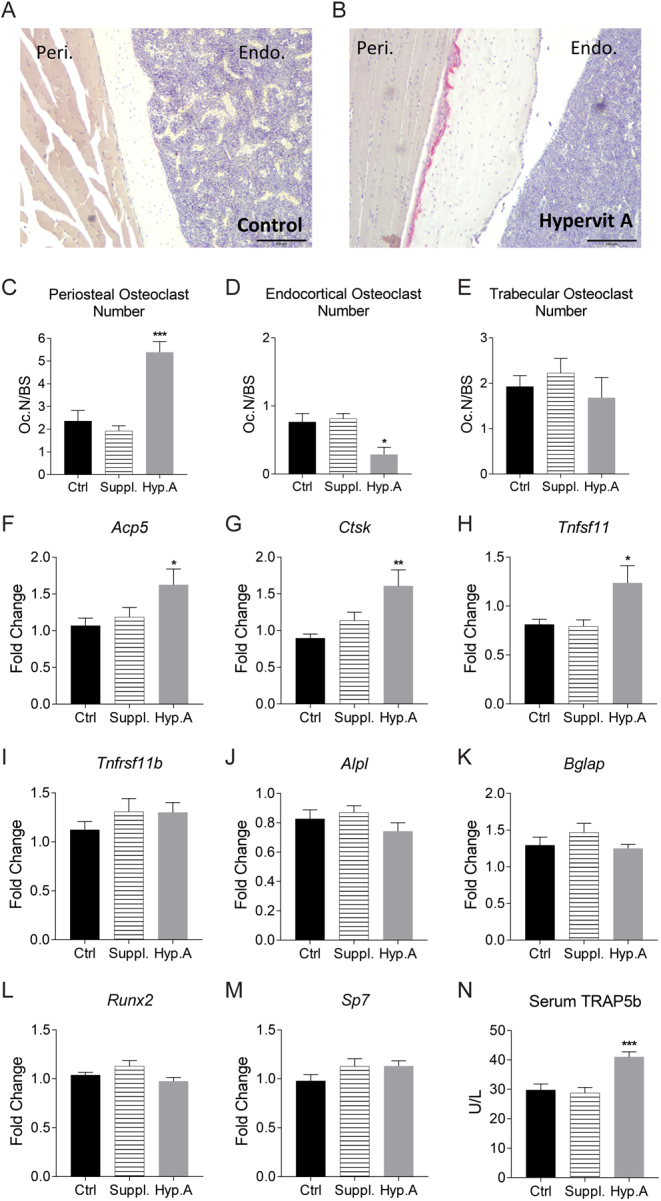
Short duration hypervitaminosis A experiment decreased cortical bone parameters, an effect caused by an increase in osteoclast number. Representative images of TRAP stained sections of femur of (A) control and (B) hypervitaminosis A treated mice for 8 days, scale bars represent 100 µm. Osteoclast numbers per measured bone surface counted from the (C) periosteum, (D) endosteum, and (E) trabeculae in TRAP stained femur sections of control (n = 10), supplemental (n = 9), and hypervitaminosis A (n = 5) mice after 8 days. Gene expression from cortical bone of the tibia of osteoclastic genes (F) Acp5 (encodes for Trap), (G) Ctsk, (H) Tnfsf11 (encodes for Rankl), (I) Tnfrsf11b (encodes for Opg) and osteoblastic genes (J) Alpl, (K) Bglap (encodes for Osteocalcin), (L) Runx2, and (M) Sp7 (encodes for Osterix) in fold change relative to control. Serum analysis of (N) TRAP5b. Figures displayed as mean ± s.e.m., 1-way ANOVA followed by Dunnett’s multiple comparison test vs control, *P < 0.05, **P < 0.01, ***P < 0.001, n = 10/group.